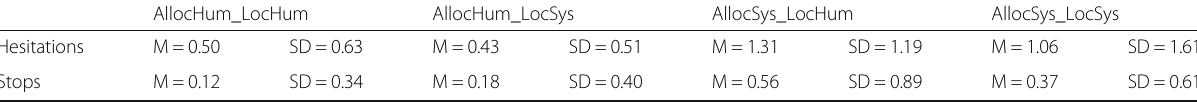
Table 6 Count of hesitations and stops across groups during the unassisted route-reversal task (mean and standard deviations) AllocHum_LocHum AllocHum_LocSys AllocSys_LocHum AllocSys_LocSys Hesitations M = 0.50 SD = 0.63 M = 0.43 SD = 0.51 M = 1.31 SD = 1.19 M = 1.06 SD = 1.61 Stops M = 0.12 SD = 0.34 M = 0.18 SD = 0.40 M = 0.56 SD = 0.89 M = 0.37 SD = 0.61 Participants barely hesitated or stopped in Phase 2. The groups AllocSys_LocHum and AllocSys_LocSys hesitated slightly more often than the other two groups, indicating uncertainty in recalling the next navigation action or in recognizing the surrounding